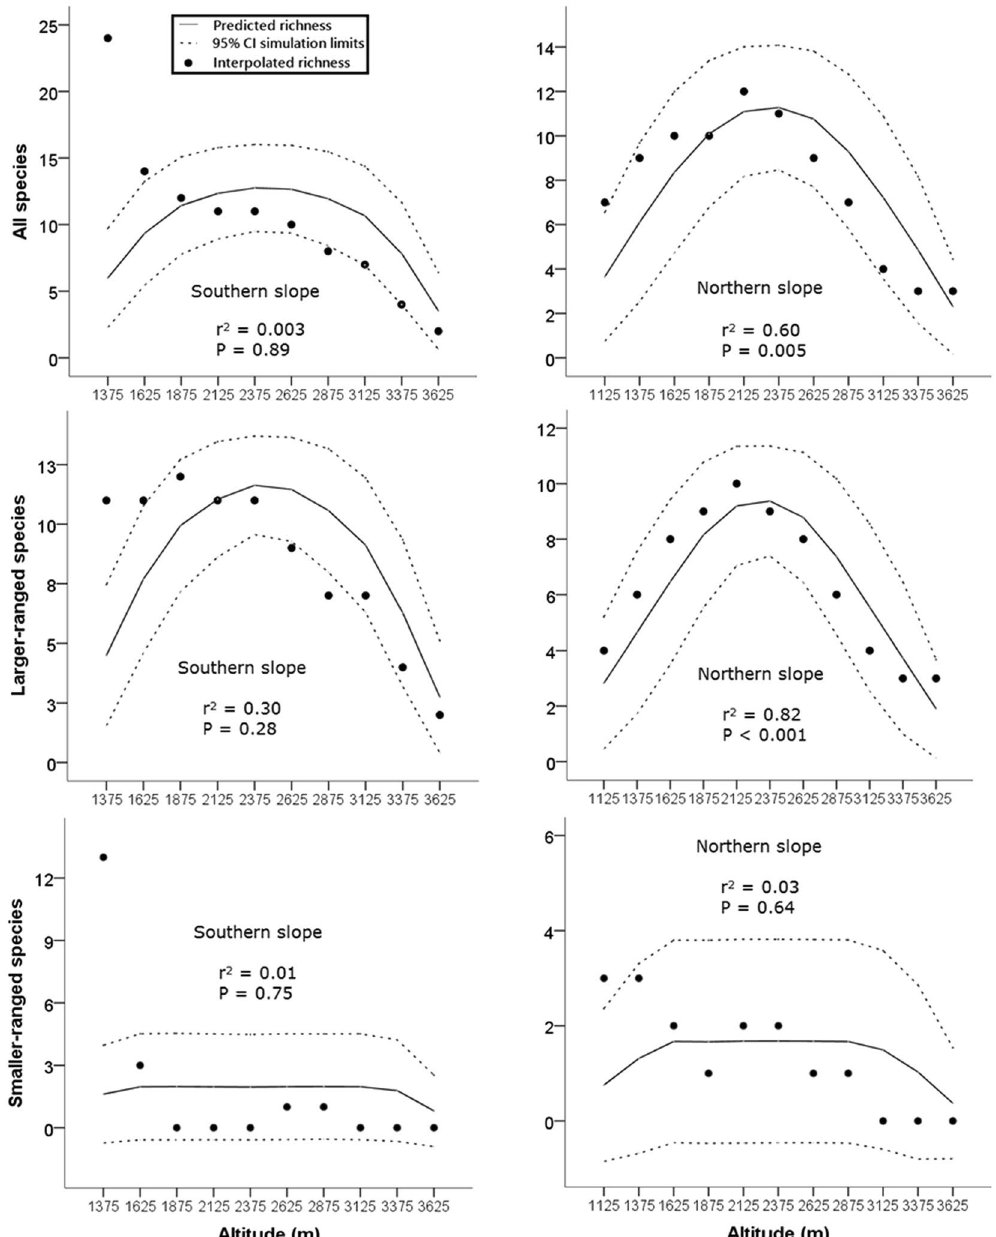
Figure 4. Rodent species richness (interpolated) along the elevational gradients on the southern and northern slopes of Mt. Taibai, China, with predicted richness and its 95% simulation limits of the mid-domain null models generated from 50,000 simulations. The r 2 and P values for each linear regression of the observed richness against the predicted richness are presented to indicate the fit of the null mid-domain effect models. Larger-ranged and smaller-ranged species are the species with elevational ranges above and below the median range size, respectively. The horizontal axis indicates the midpoints of the elevational